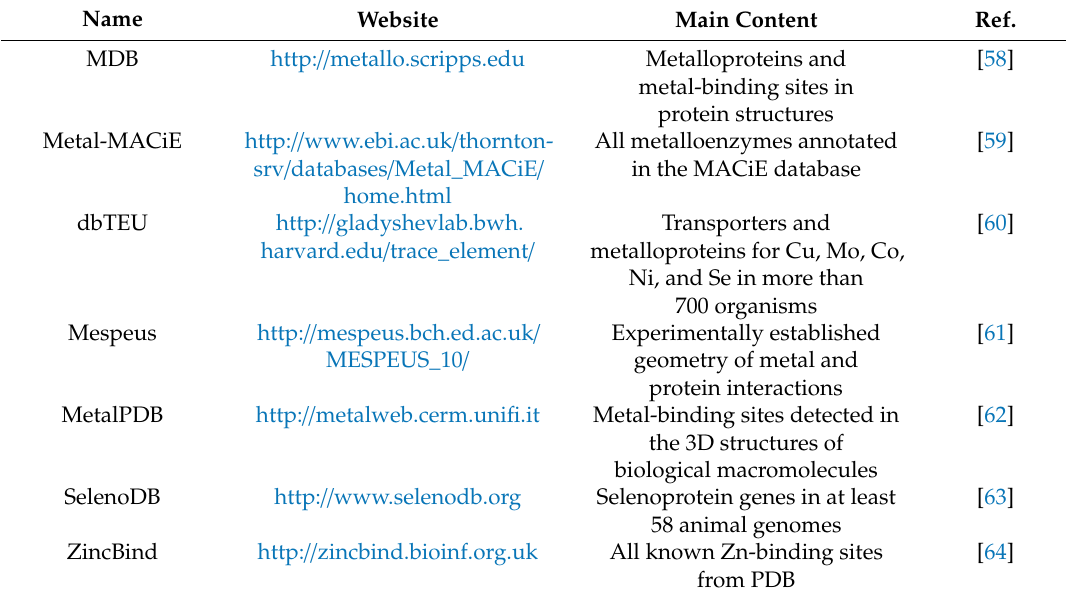
Table 2. Metalloprotein